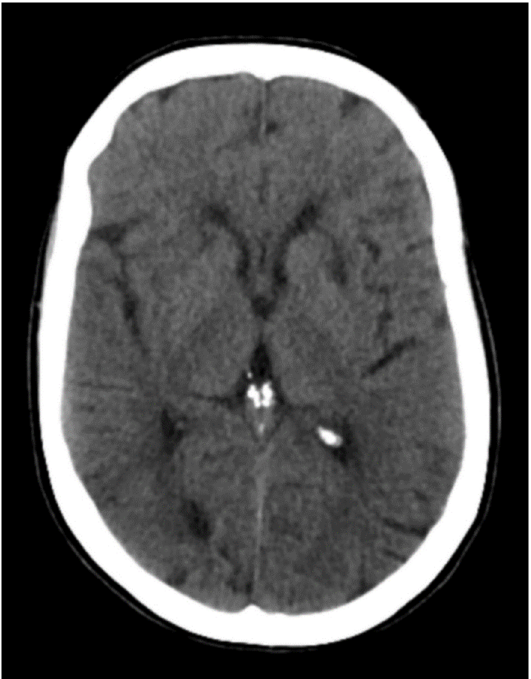
Figure 1. No intra- or extra-axial bleeding signs of acute ischemia (ASPECTS 10) or occupying lesions were observed in the simple cranial CT.